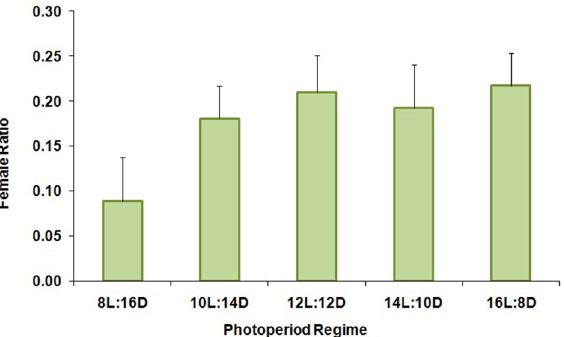
Figure 3. Female ratio (female:male ± SE) in adults that had been emerged from P. interpunctella larvae reared at 17 °C and different photoperiod regimes.